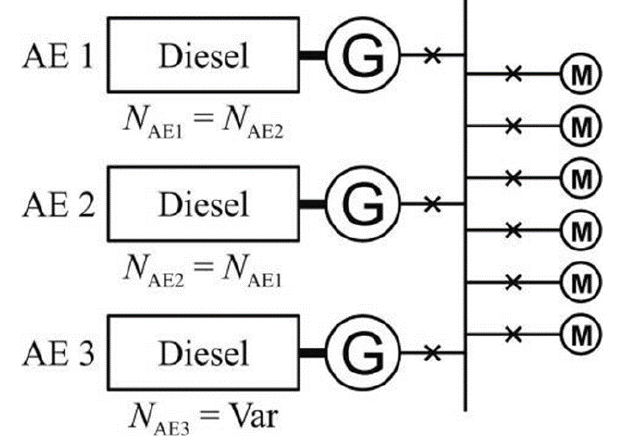
Figure 4. Auxiliary power plant of a Bulk Carrier class ship with a deadweight of 34,630 tons (AE — auxiliary engine, G — generator, M — motor).